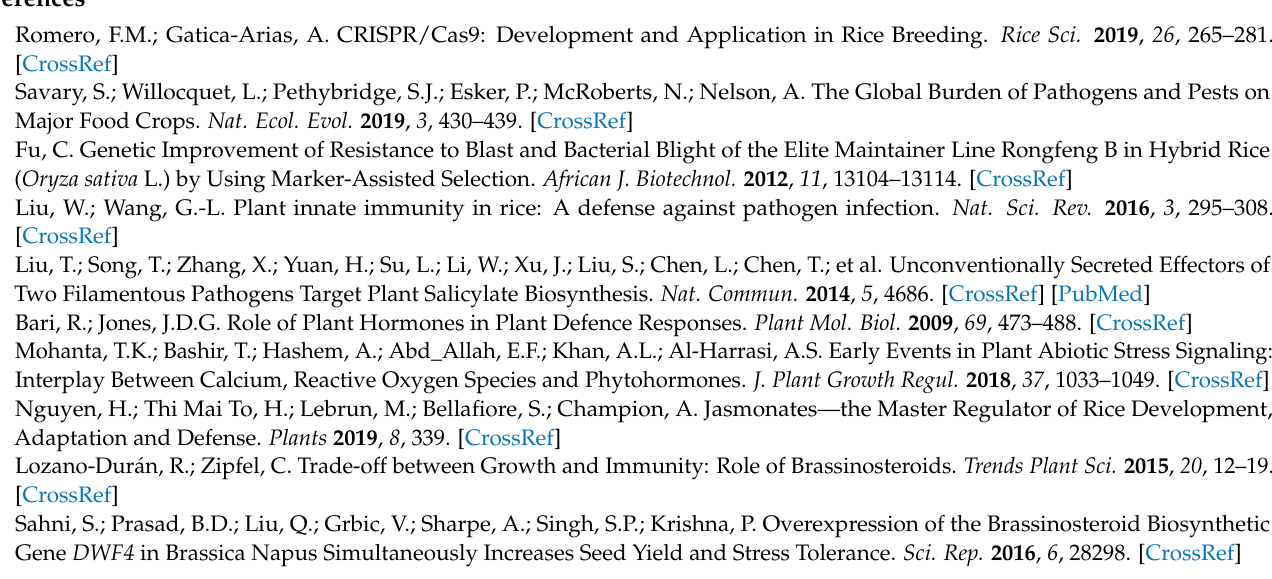
plementary Table S3: Analysis of transcription factor binding sites (TFBSs) in putative promoter sequences of OsCBP60s and AtCBP60s . The 1000 bp and 2000 bp upstream sequences of rice and Arabidopsis CBP60 genes were retrieved from Phytozome and TAIR, respectively. The CAMATA, TGACG and W-box binding sequences were identified using Plant PAN 3 software. The BES1 and BZR1 TFBSs were identified